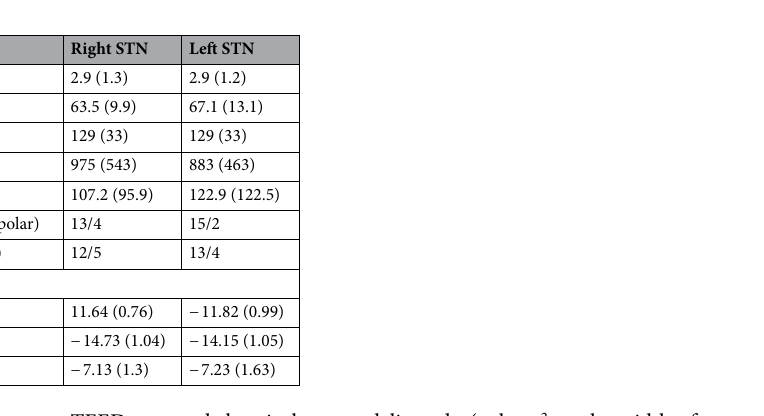
Table 2. DBS Parameters. TEED 1sec = total electrical energy delivered = (voltage 2 × pulse width × frequency)/